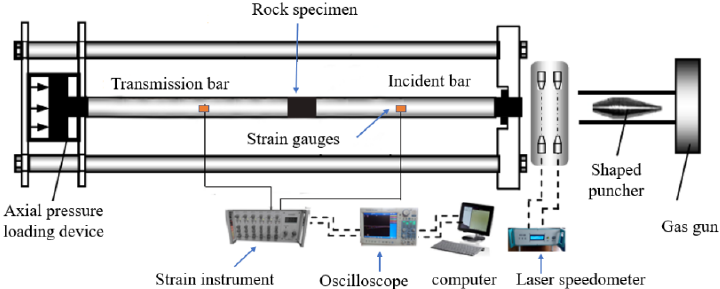
Figure 3. Split Hopkinson pressure bar (SHPB).